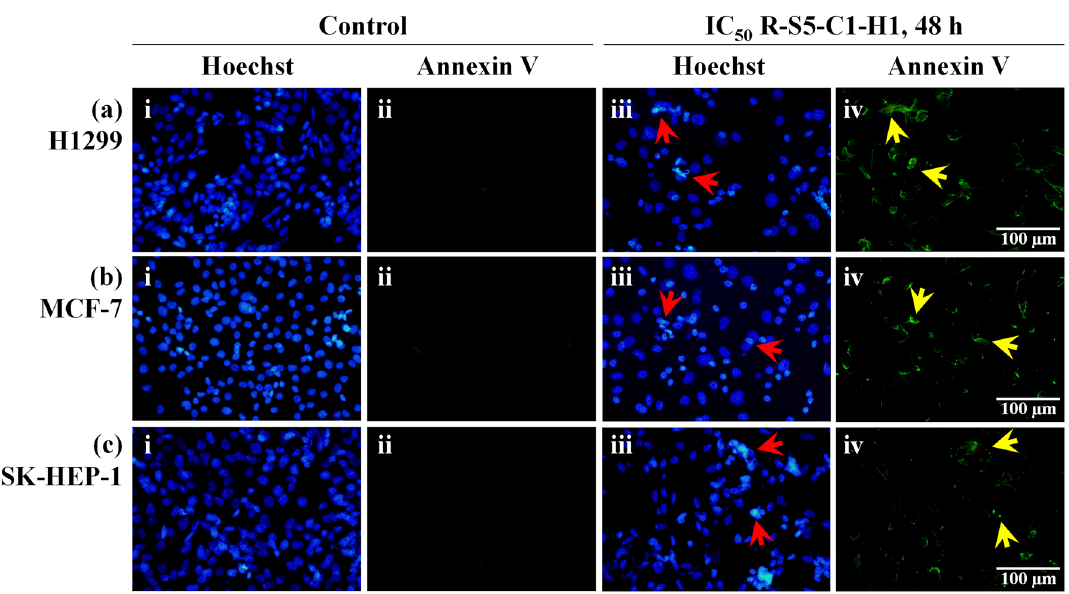
Figure 4. Morphological changes in apoptotic H1299 ( a ), MCF-7 ( b ), and SK-HEP-1 ( c ) cells following treatment with IC 50 of R-S5-C1-H1 for 48 h, observed by fluorescence microscopy. Hoechst 33342 staining (blue) and Annexin V staining (green) were used to detect apoptotic cells in untreated control (i and ii) and treatment (iii and iv) groups. Red arrows indicate nuclear condensation (bright blue), while yellow arrows indicate phosphatidylserine